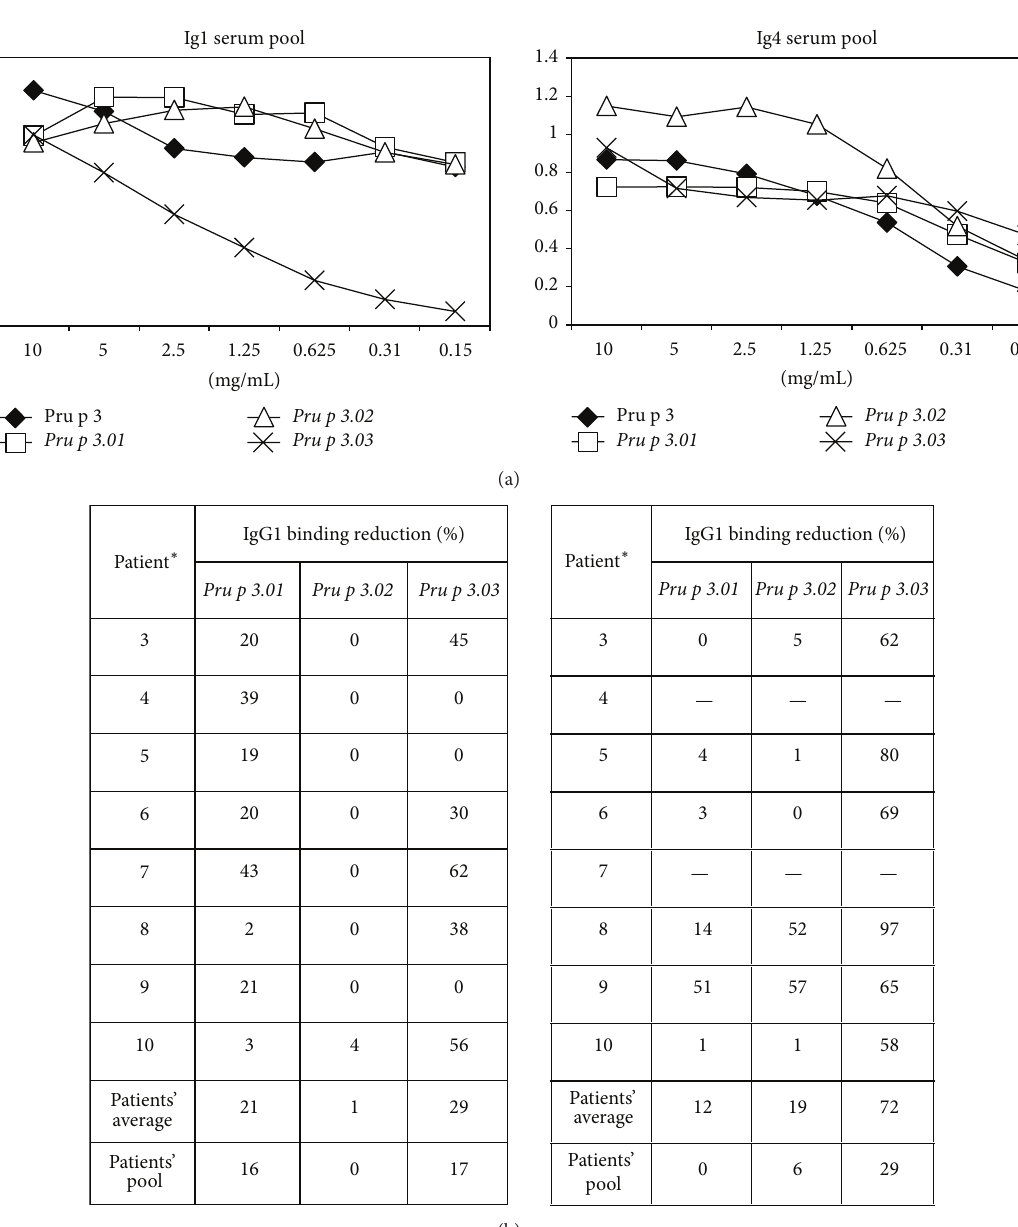
Figure 3: (a) Specific IgG1 and IgG4 to Pru p 3 forms (wild type, Pru p 3.01, Pru p 3.02 , and Pru p 3.03 ), using serum pool from peach-allergic patients (1: 10 dilution). Blocking solution without solid phase was used as a negative control, and optical density (OD) values > 0.086 units ( 𝑛 = 20 ; mean + 3x SD = 0.05 + 3 × 0.012 OD units) were considered positive. All tests were performed in triplicate. (b) Reduction of IgG1 and IgG4 binding capacity (%) of the mutants in comparison with Pru p 3 was calculated by taking the value of Pru p 3 (5 𝜇 g/mL) to represent 100% in each serum sample. ∗ The number of the patients corresponds to that in Table 1. − , negative value, represents those patients with negative IgG4 for Pru p